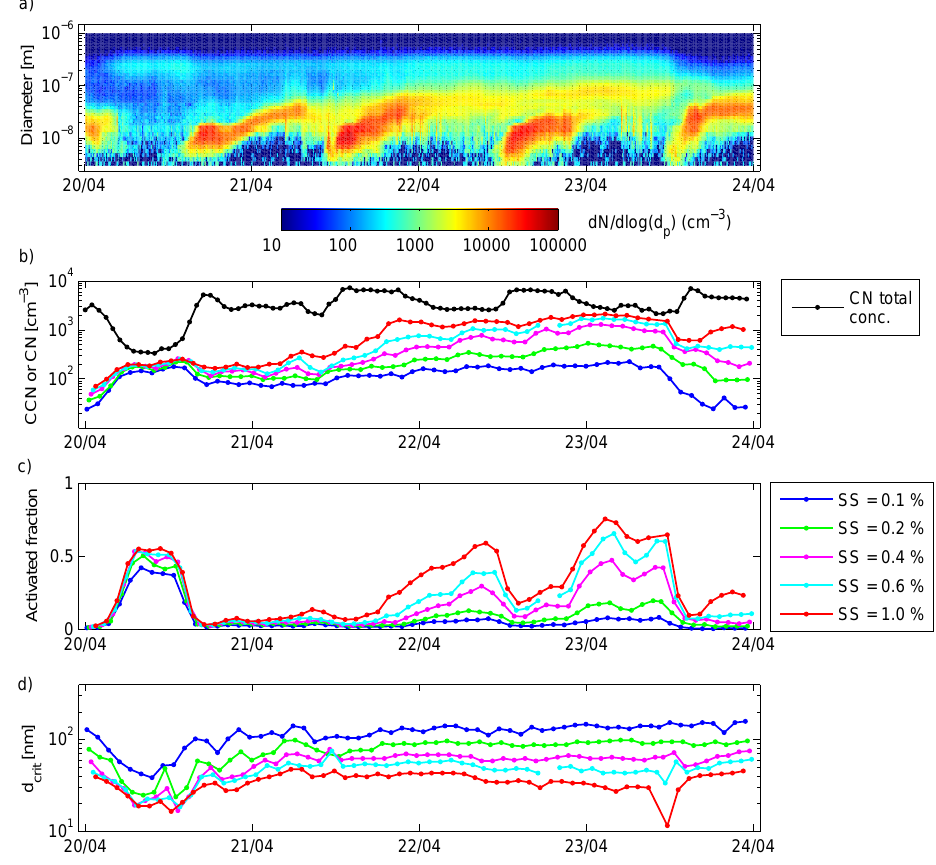
Fig. 6. Comparison of the time evolution of (a) particle size distributions, (b) cloud condensation nuclei (CCN) and total particle concentra- tions (CN), (c) activated fraction (CCN/CN), and (d) critical diameter (estimated from CCNC and size distribution measurements) on